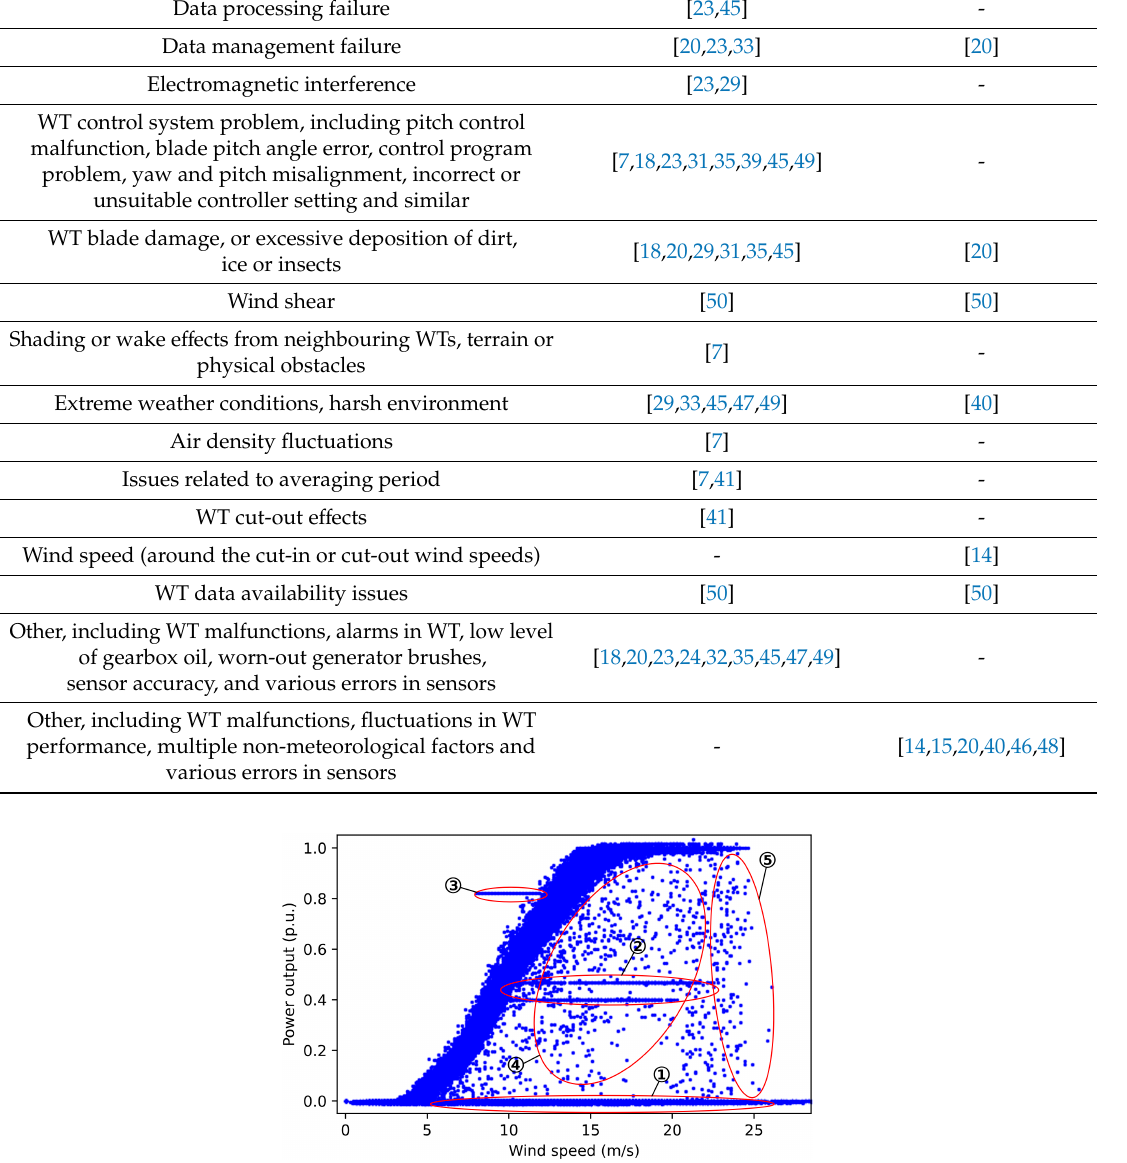
Figure 1. Actual 3-year measurements with indicated different types of outliers for an individual WT.